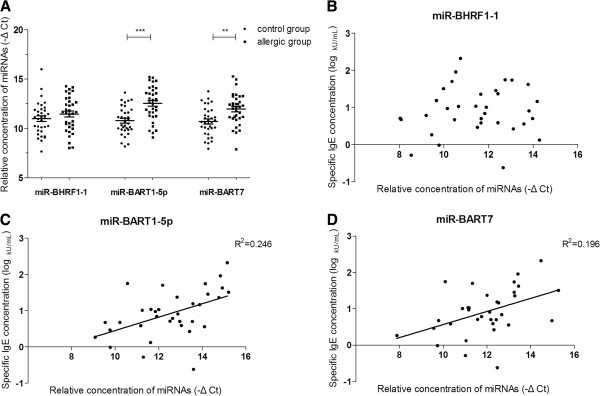
Viral miRNAs expression in food allergic and control groups. (A) Mean + (5–95) percentile (error bars) of EBV miR-BHRF1-1, miRBART1-5p and miR-BART7 concentrations in 34 food allergic patients and 34 healthy controls. Viral miRNAs concentration is normalized to that of U6 RNA and is presented as –ΔCt, where Ct is the threshold cycle. **, p < 0.01; ***, p < 0.001, by t test; (B) the correlation between egg-specific IgE and miR-BHRF1-1 (p > 0.05, by multiple linear regression); (C) between egg-specific IgE and miR-BART1-5p (p < 0.01); and (D) between egg-specific IgE and miR-BART7 (p < 0.01). R2 values are indicated.